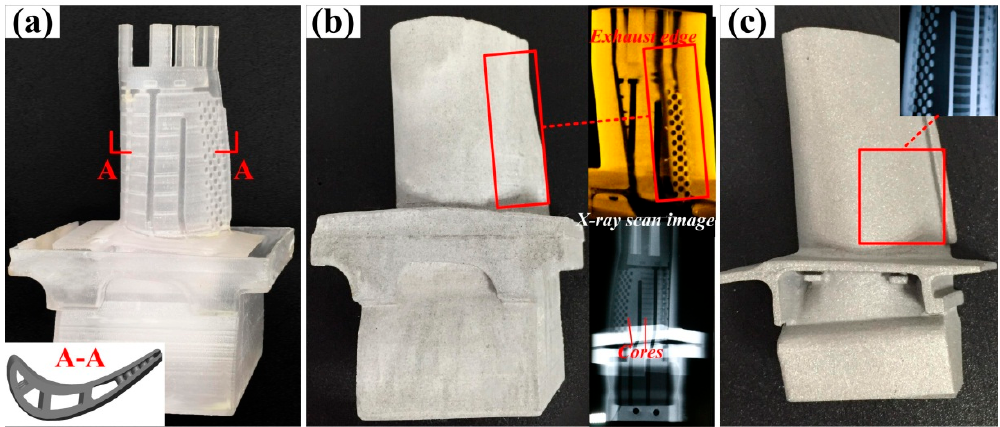
Figure 10. Fabrication of a hollow turbine blade: ( a ) Resin mold; ( b ) Mullite whisker-reinforced ceramic mold with X-ray inspection; ( c ) Hollow turbine blade.